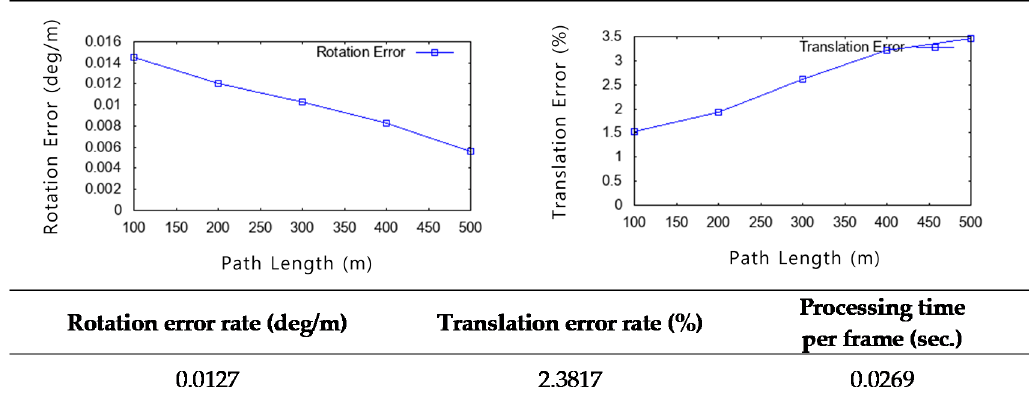
Figure 17. Graph of error over mileage for sequence 03.